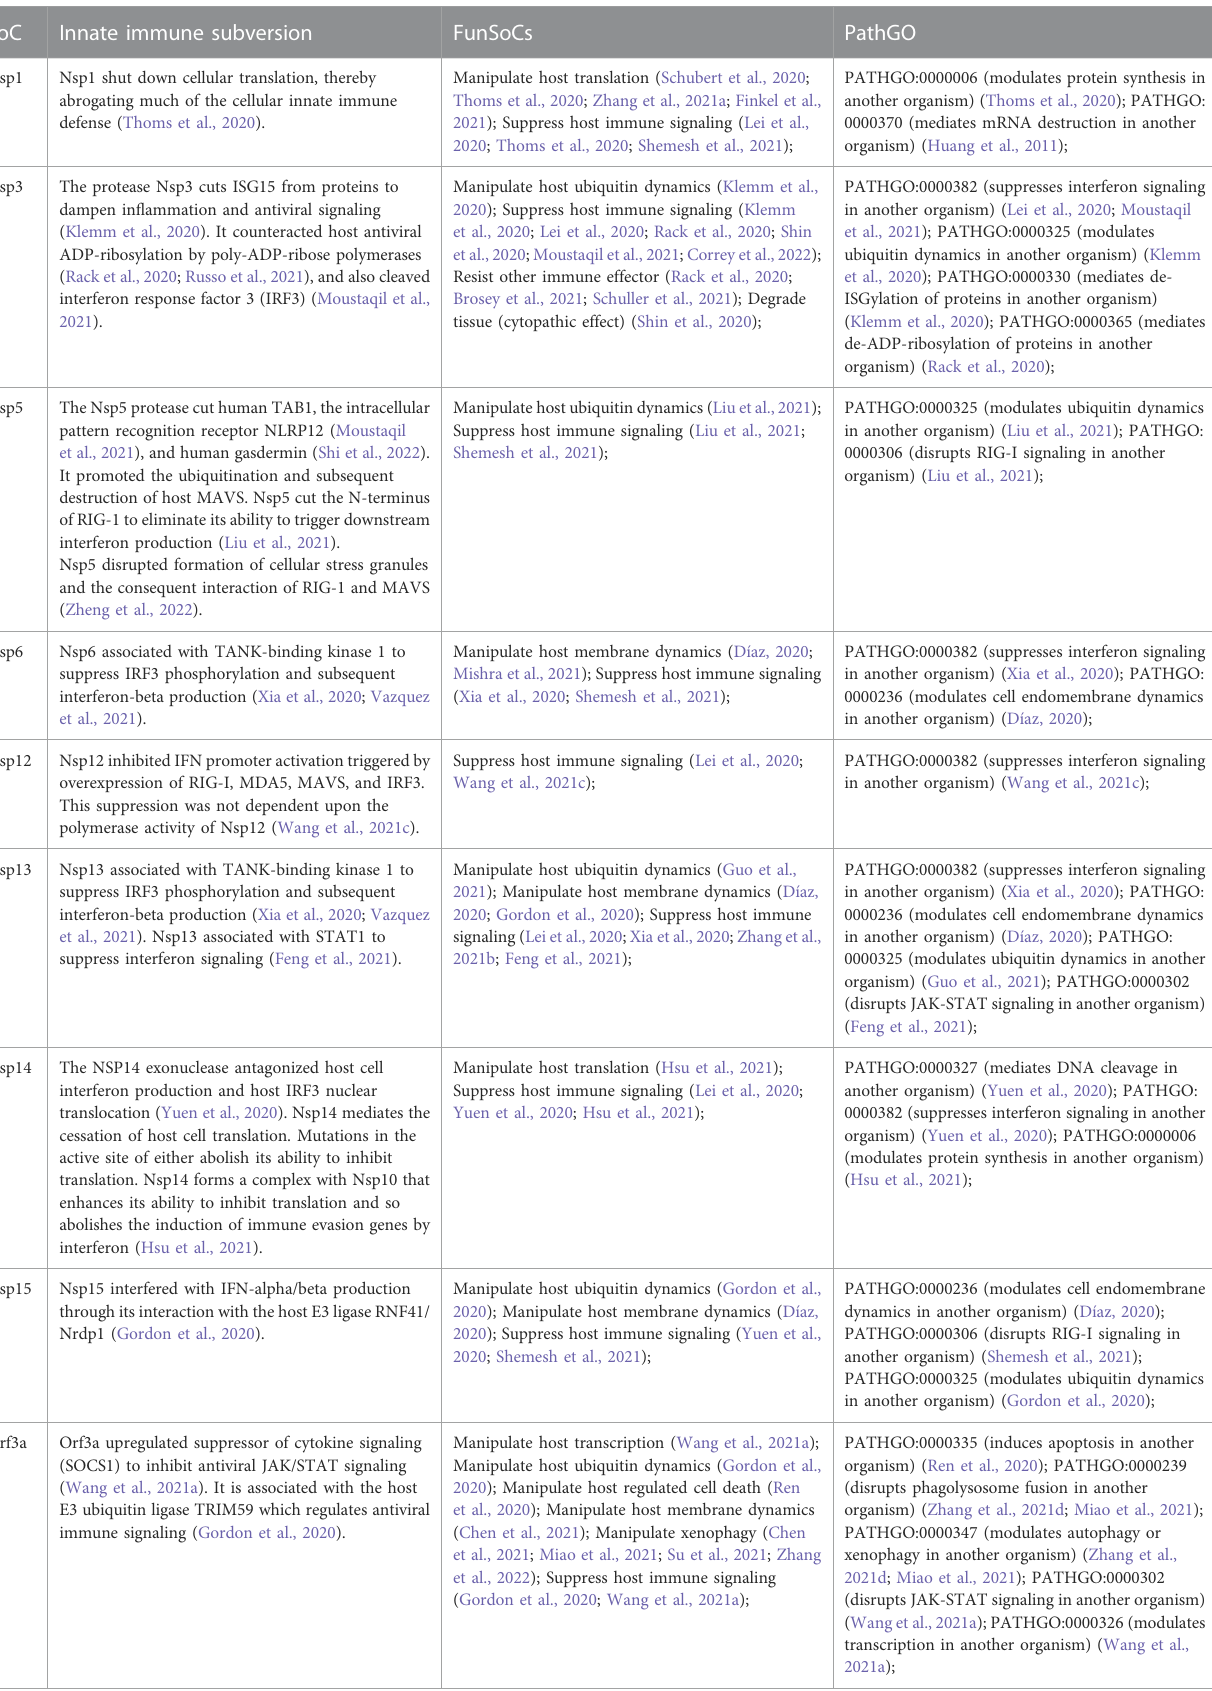
TABLE 3 SARS-CoV-2 encoded proteins directly involved in host immune